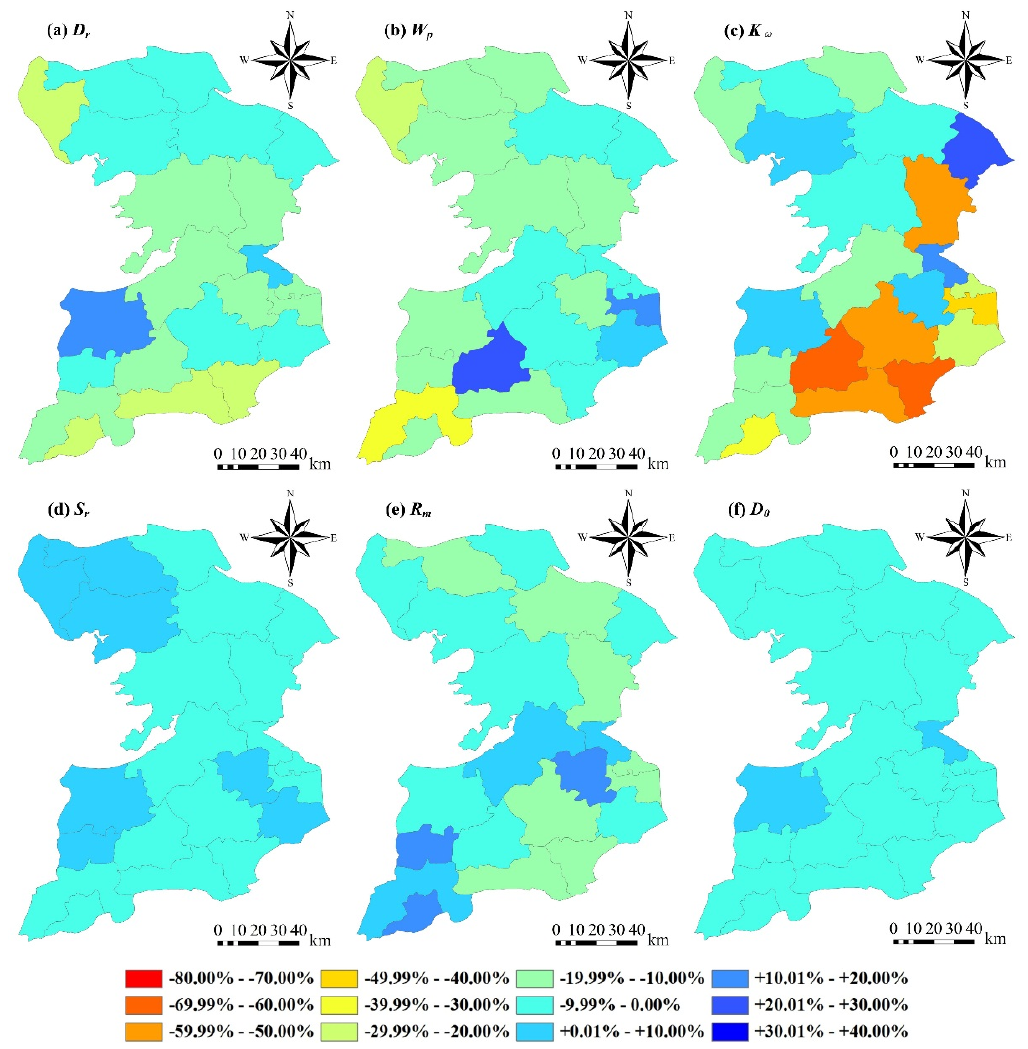
Figure 5. Spatial difference of river systems changes in the Taihu Region during the 1980s to